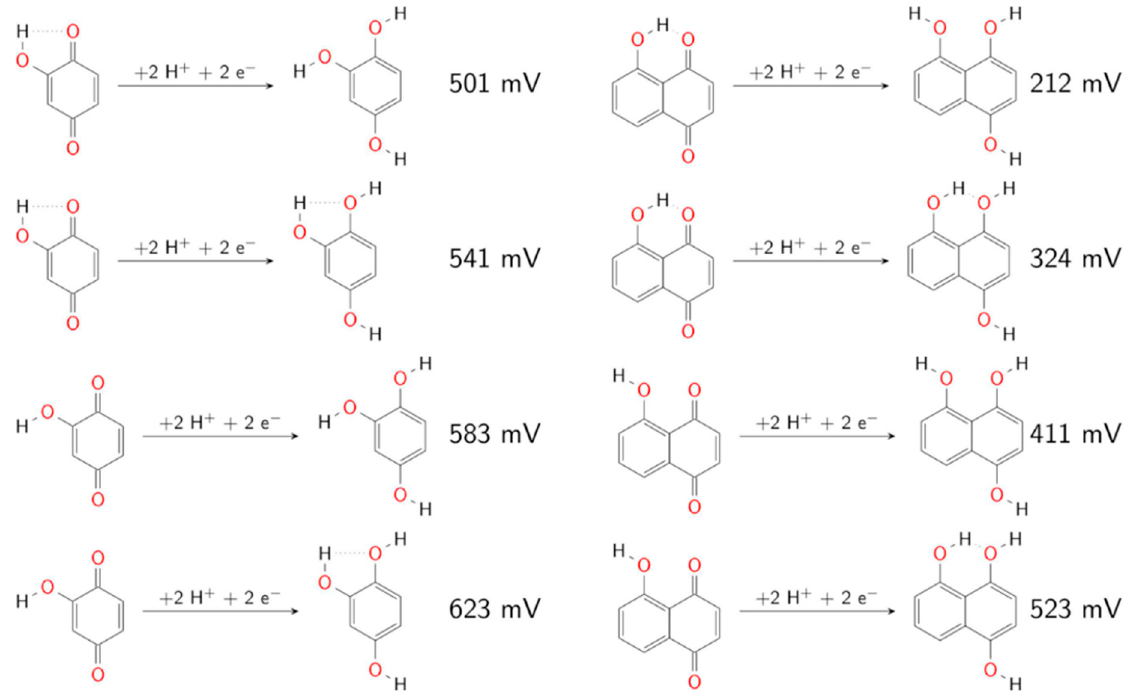
Figure 7. Comparison between various orientations of the hydrogens on hydroxyl groups that result in drastic differences in the relative energies of the conformers for benzoquinones ( left ) and naphthoquinones ( right ). Reprinted with permission from Ref. [42]. 2022, John Wiley and Sons.